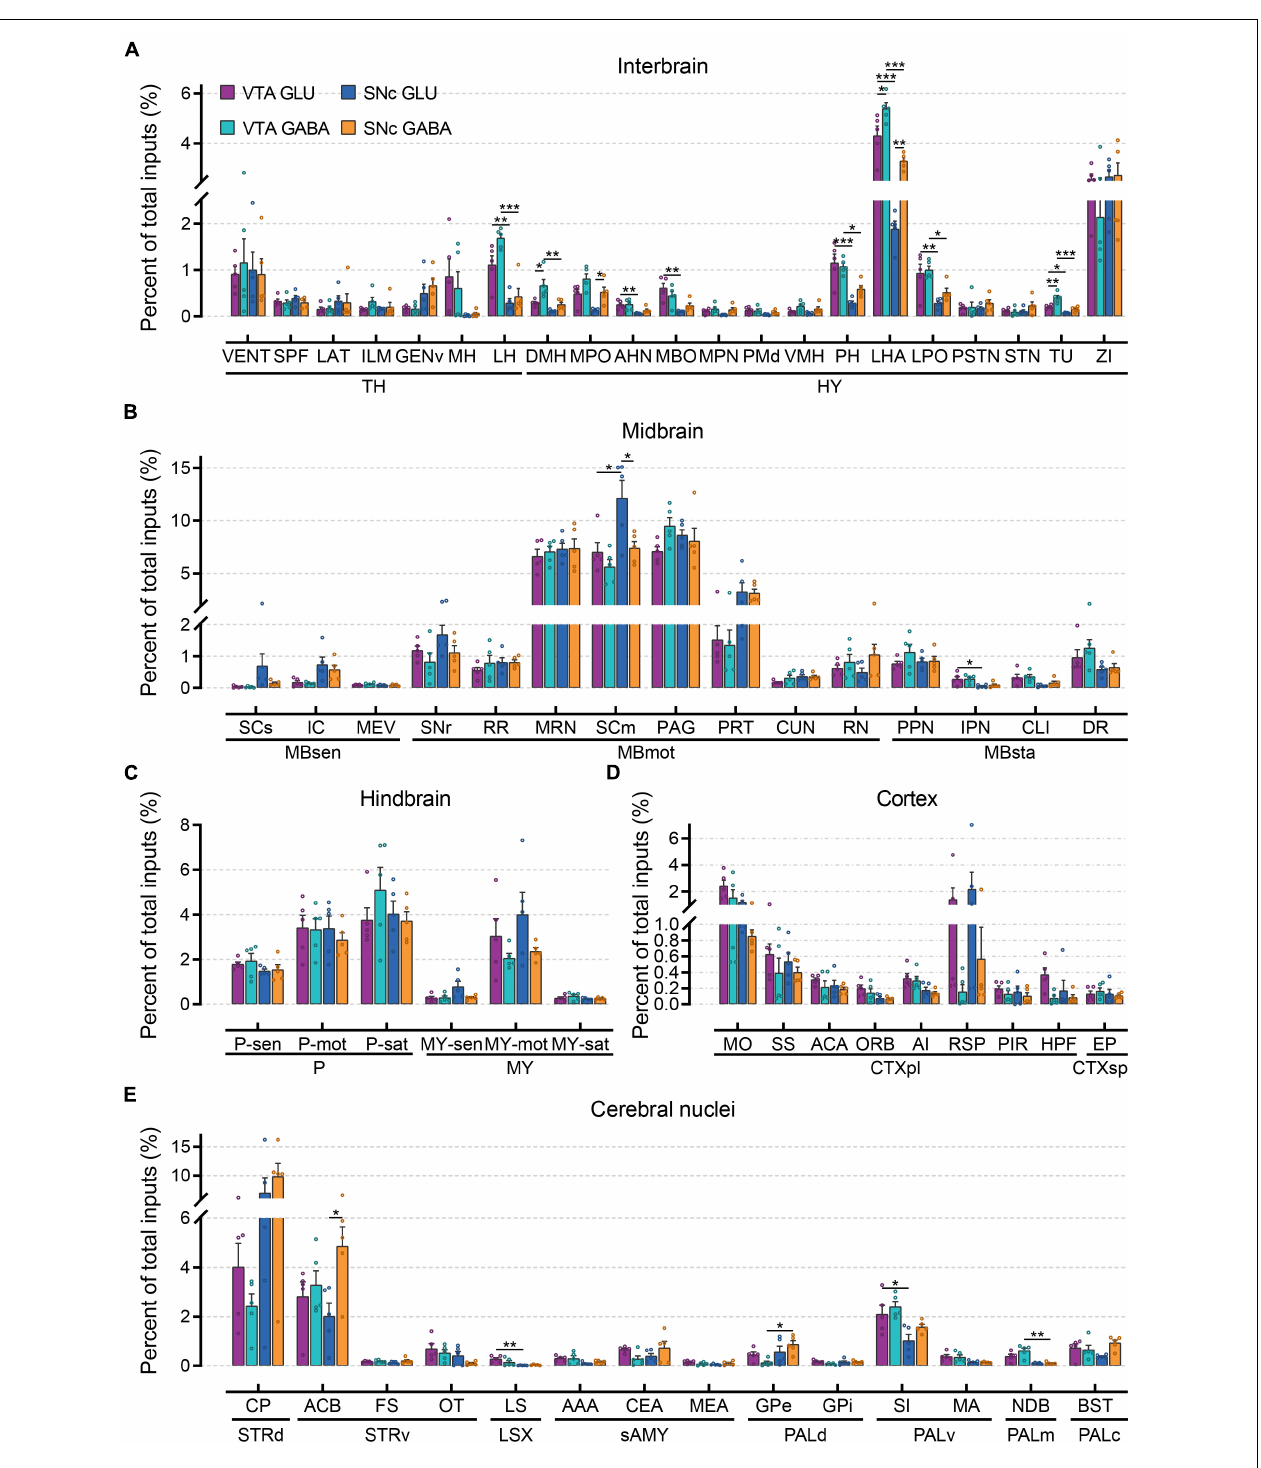
FIGURE 4 | Quantitative comparisons of whole-brain input to glutamatergic and GABAergic neurons in VTA and SNc in individual brain regions. (A) Proportions of total inputs from interbrain region. (B) Proportions of total inputs from midbrain region. (C) Proportions of total inputs from hindbrain region. (D) Proportions of total inputs from cortex region. (E) Proportions of total inputs from cerebral nuclei region. Mean ± SEM ( n = 5 mice each for the VTA GLU, VTA GABA, SNc GLU, and SNc GABA groups). *** p < 0.001, ** p < 0.01, and * p < 0.05. Only significant differences between the same cell type in different brain regions or between cell types in the same brain regions are marked; one-way ANOVA followed by Tukey’s post hoc tests. Abbreviations of the 67 brain regions and their percentages of inputs are listed in Supplementary Table 1 and Data 1 .